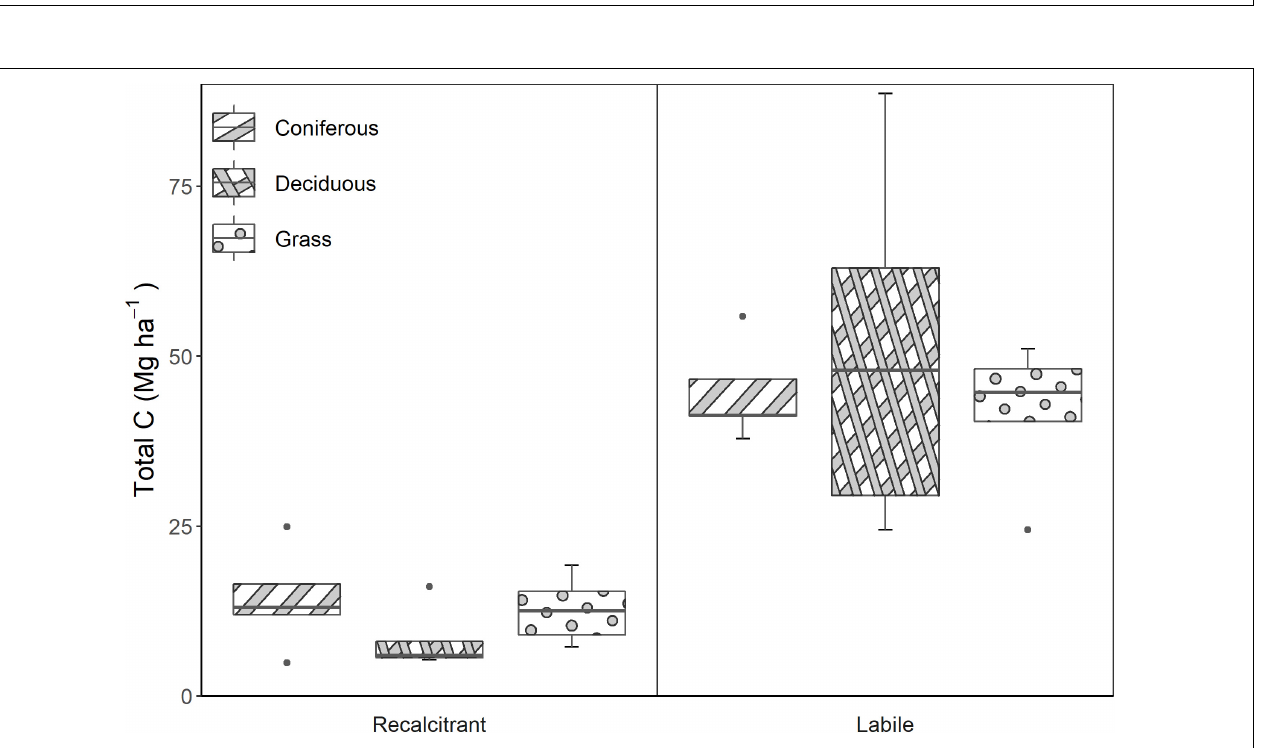
FIGURE 3 | Total C in chemically resistant and chemically oxidizable pools in the three reclaimed vegetation treatments. There were no significant differences among treatments.